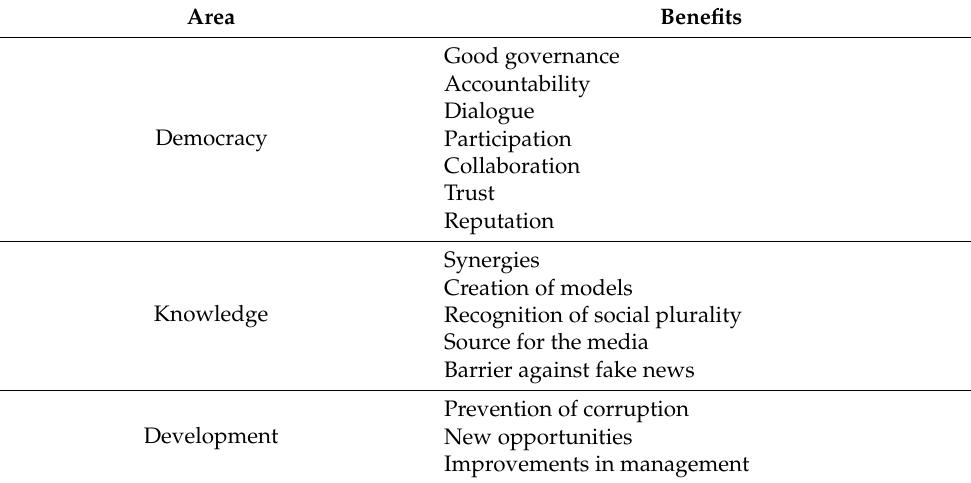
Table 1. Benefits of